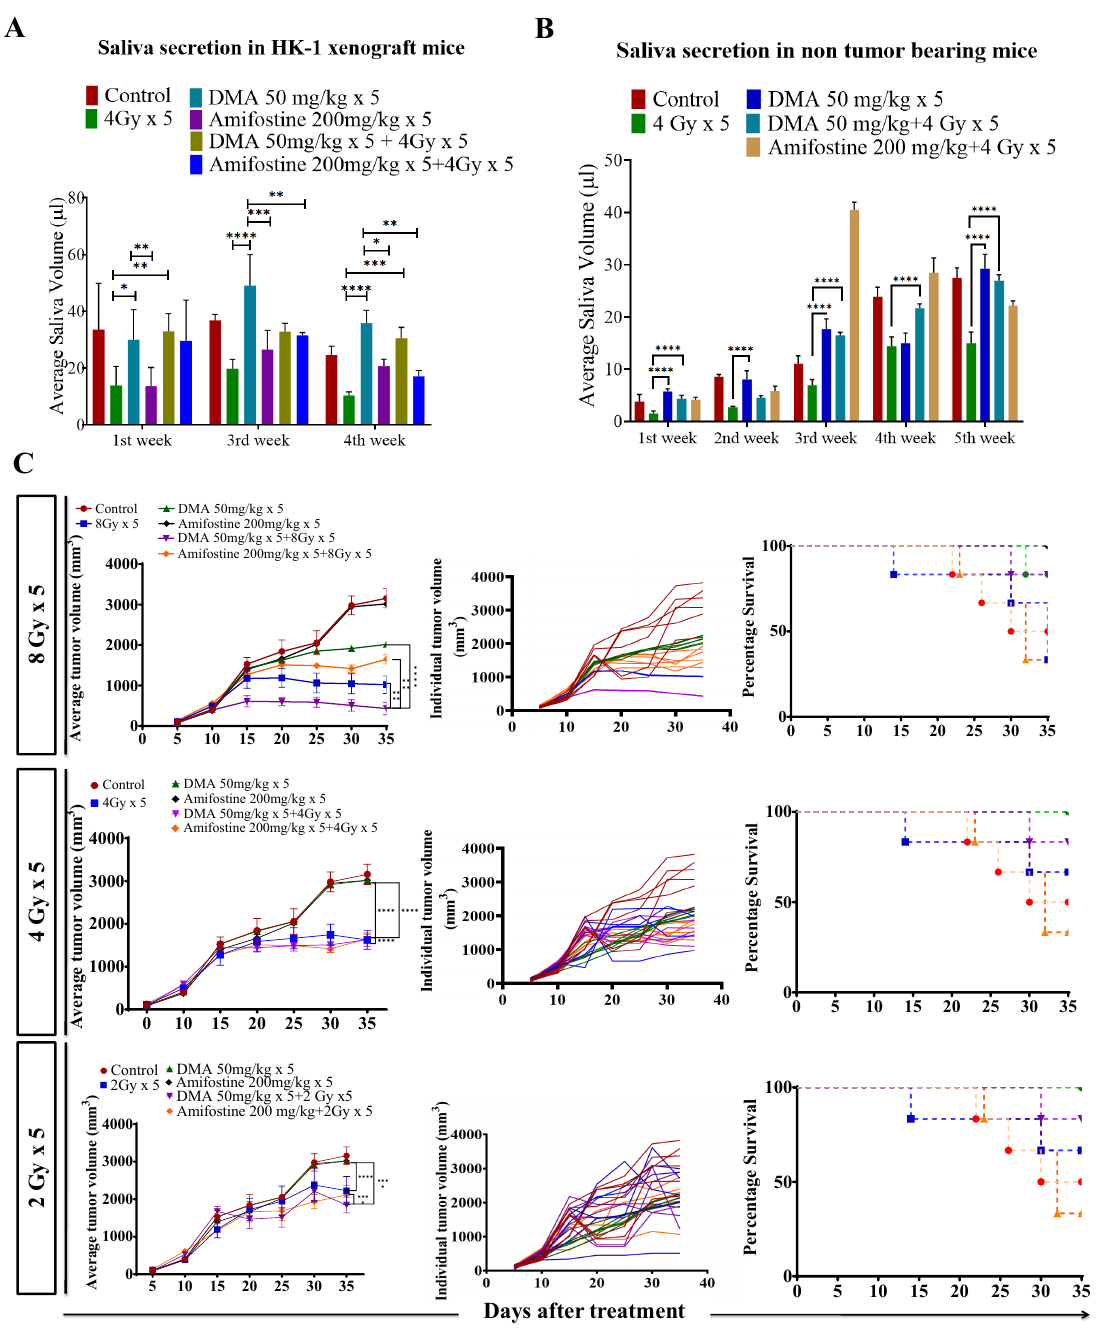
Figure 2. DMA restores saliva secretion and causes the enhancement of radiation-induced tumor growth delay (TGD) with an increasing radiation dose per fraction in the HK-1 xenograft mouse model. The animals were divided into four groups: control (tumor-bearing), radiation-treated, DMA-treated, and DMA + radiation-treated mice. Measurement of stimulated saliva secretion in ( A ) HK-1 xenograft-bearing nude mice for the first, third, and fourth week and ( B ) non-tumor-bearing NCr- FoxN1 nu nude mice. ( C ) HK-1 xenograft was treated with IR schedules of 8 Gy × 5, 4 Gy × 5, and 2 Gy × 5 fractions alone and in combination with DMA given once per day for 5 days, 2 h before irradiation. Average tumor volumes (left column), individual tumor volumes (middle column), and Kaplan–Meier analysis for survival are shown. All animal cohorts contained n = 6 animals per group. Data were analyzed using two-way ANOVA followed by Tukey’s multiple comparisons. p -values at * < 0.05, ** < 0.005, *** < 0.0005, and **** < 0.00005 indicate statistical